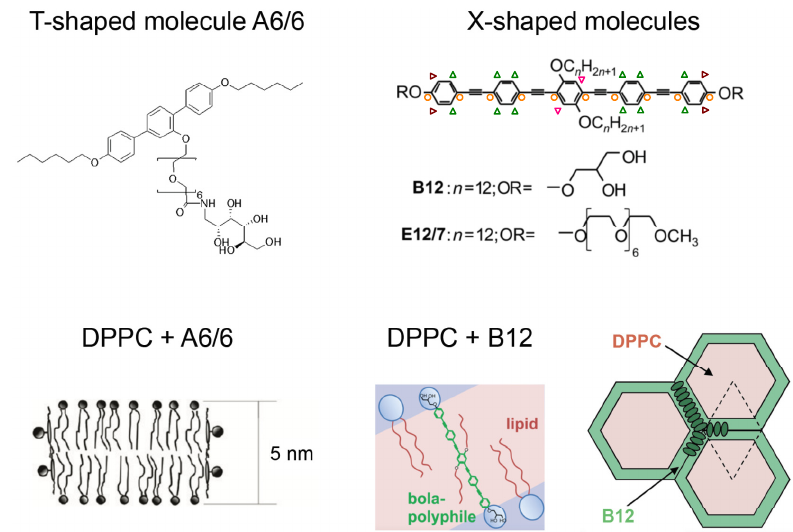
Figure 2. Chemical structures of various bolapolyphiles ( top ); and schemes of their modes of interaction with lipid bilayers ( bottom ). Assigned groups of 13 C resonances of the aromatic core of the X-shaped molecules are marked by different symbols (circles and triangles). Figure adapted from refs. [21–23] with permissions from the publishers. Copyrights 2015 John Wiley& Sons and 2016 Americal Chemical